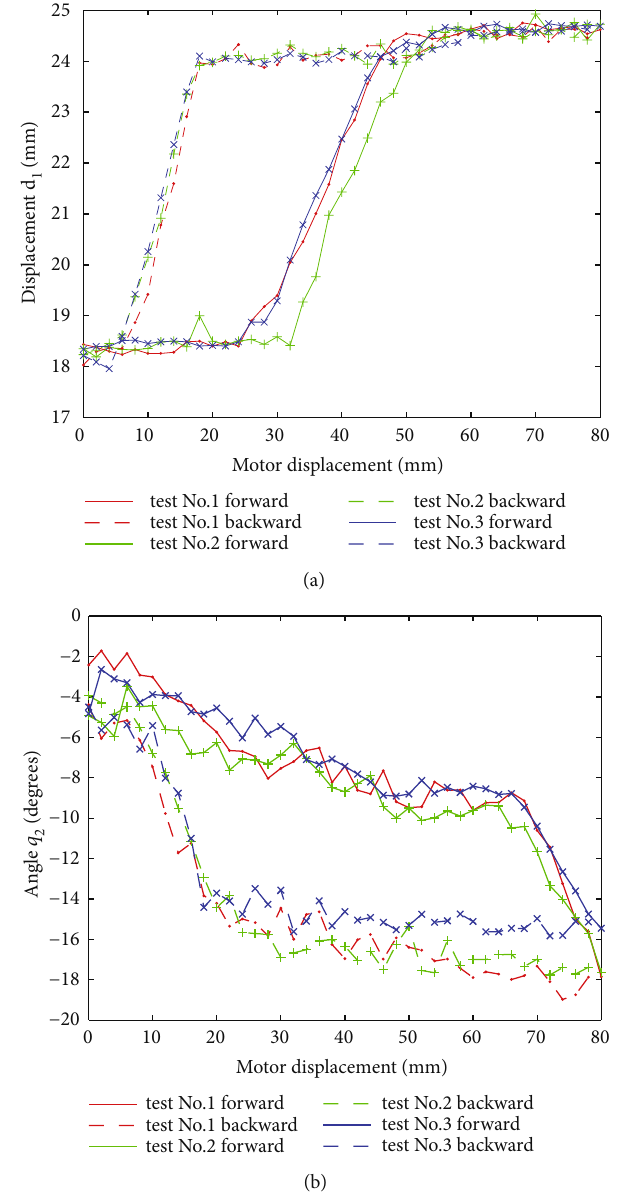
Figure 11: Repeatability with respect to movement of volunteer no.